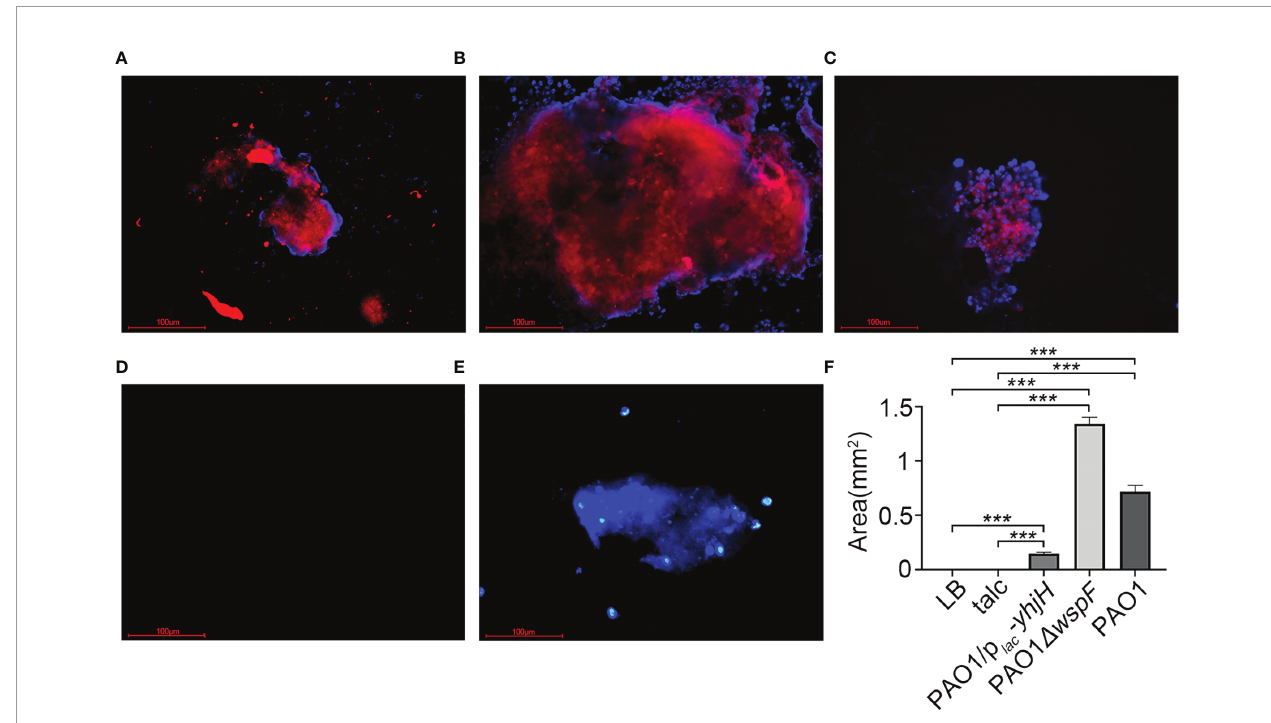
FIGURE 5 | The PNA-FISH of fi brinous deposition in the purulent exudate 7 days after inoculation. The PNA-FISH kit used a Pseudomonas aeruginosa -speci fi c probe (red) and a non-speci fi c nucleic acid stain DAPI (blue) to identify bio fi lms (×40). The fi gure showed that the bacteria were surrounded by host cells in (A – C) . In red the aggregate, and in blue the polymorphonuclear leukocytes surrounding the aggregate. (A) PAO1 group. (B) PAO1 D wspF group. (C) PAO1/p lac -yhjH group. (D) LB control group. (E) Talc control group. (F) Bio fi lm size measured by PNA-FISH. Results displayed as the mean ± SD. *** p < 0.001 versus LB and talc control groups (control group), and the differences among the infection groups were statistically signi fi cant. ANOVA test was used to compare group differences (600 × 600 DPI). PNA-FISH, peptide nucleic acid fl uorescence in situ hybridization; DAPI, 4,6-diamino-2-phenylindole; LB, Luria – Bertani; talc, magnesium